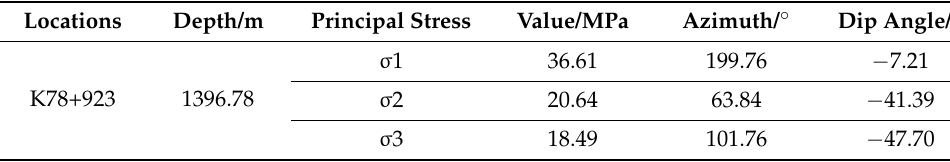
Table 8. Calculation results of ground stress.